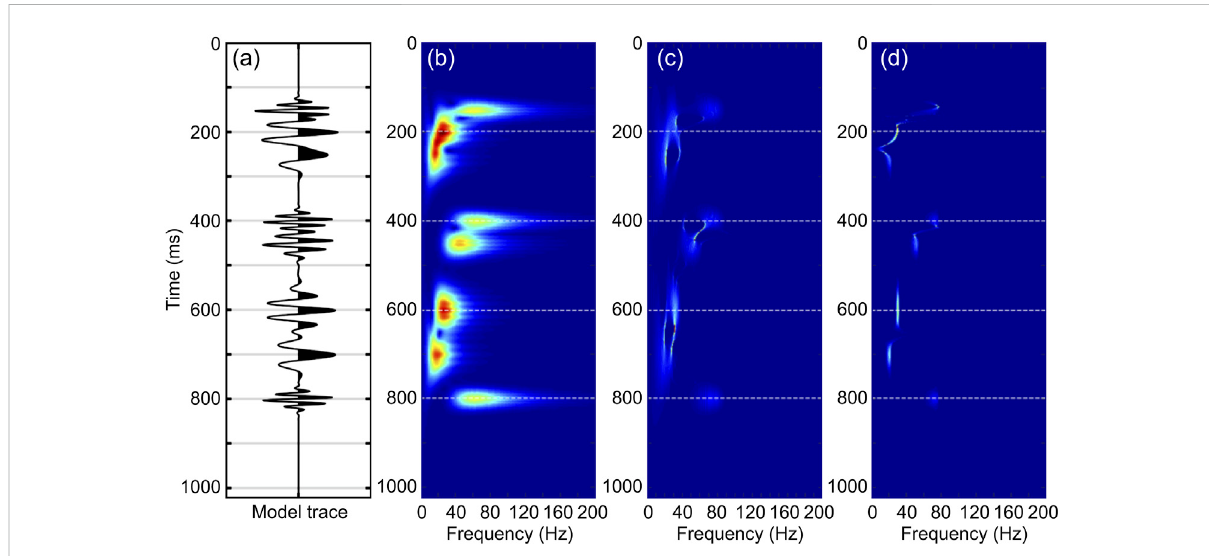
FIGURE 3 Application of the synthetic seismic trace. (A) Original synthetic seismic trace with noise; the signal is composed of two 20 Hz zero-phase Morlet wavelets, with scale = 1 at 250 and 700 ms; two 30 Hz zero-phase Morlet wavelets, with scale = 2 at 200 and 600 ms; three 50 Hz Morlet wavelets, with phase = π /2 and scale = 2 at 150, 400, and 800 ms; and a 40 Hz Morlet wavelet, with phase = π /2 and scale = 2 at 450 ms; (B) time – frequency spectra of synthetic seismic trace using the continuous wavelet transform (CWT); (C) time – frequency spectra of the synthetic seismic trace using the CWT-based synchrosqueezing transform (SST); and (D) time – frequency spectra of synthetic seismic trace using our improved SST. [ (B – D) are plotted with MATLAB, with the “ jet ” colormap; red indicates higher